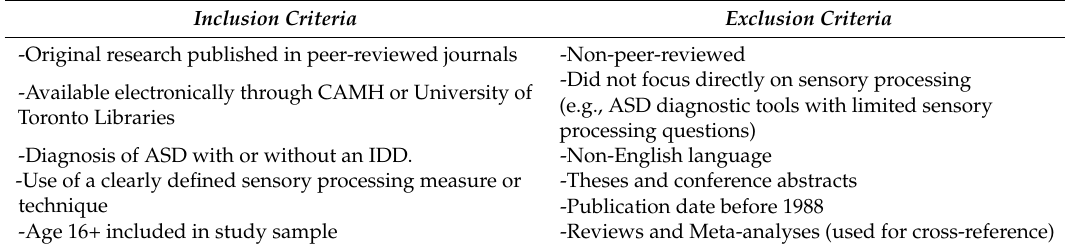
Table 1. Empirical Studies–Eligibility